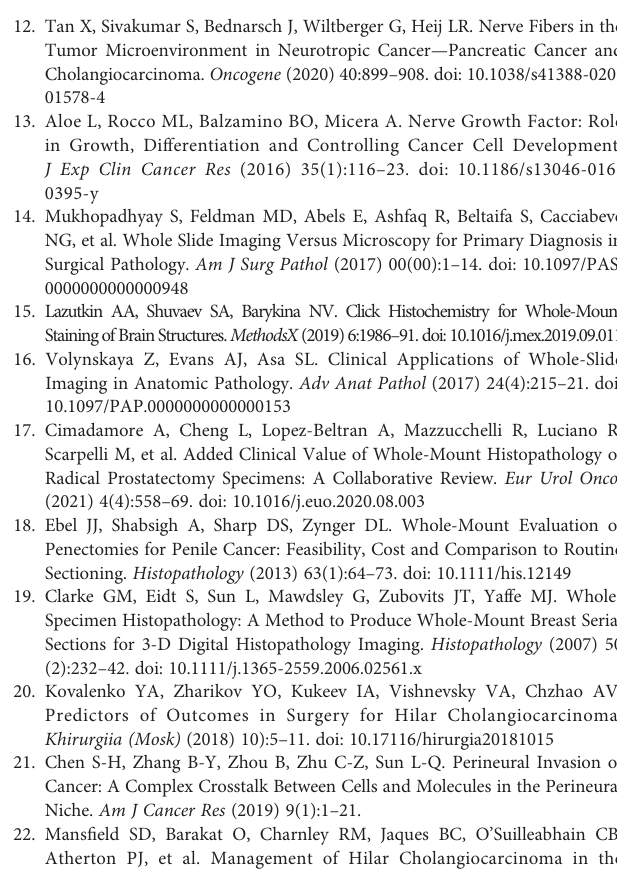
Supplementary Figure 1 | Histologic tissue sampling, second tissue sampling, and paraf fi n embedding of hilar cholangiocarcinoma (HCCA) pathological tissue. (A) Whole-mount histologic large sections (WHLS) taken along the axial CT direction. (B) Pathological tissue sampling after second fi xation. (C) Paraf fi n embedding of HCCA pathological tissue. (D) HCCA pathological tissue embedding being